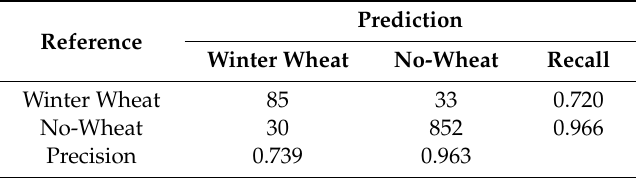
Figure 12. Historical winter wheat distribution map (2016–2017 growing season) informed by ( a ) RF and ( b ) A-LSTM, ( c ) the distribution of manually collected evaluation samples from the Planet Explorer API. Table 7. Confusion matrix of the prediction map informed by RF. Table 6. Confusion matrix of the prediction map informed by RF.